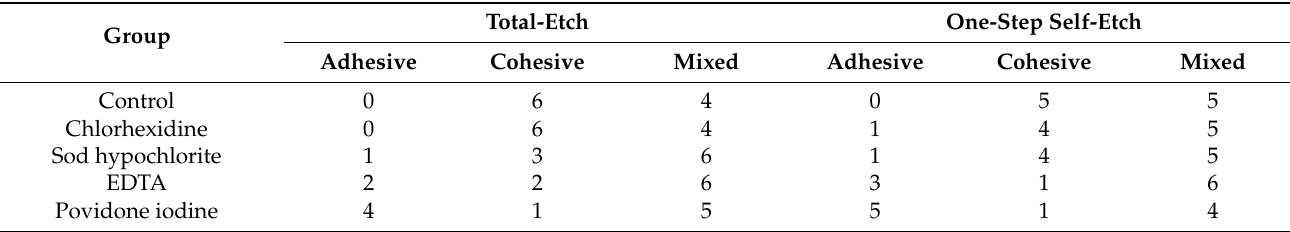
Table 5. Fracture mode recorded for each group (in